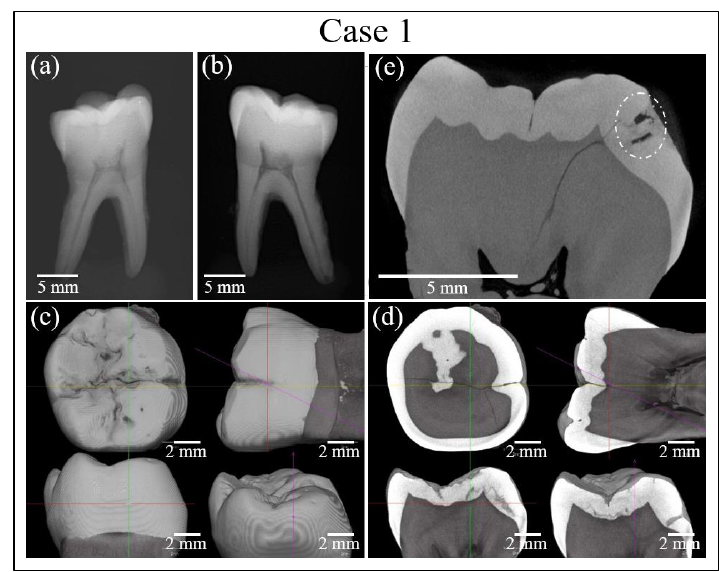
Figure 3. ( a , b ) Results of conventional X-ray analyses of the tooth sample in Case 1. ( c – e ) High-resolution micro-CT scanning examinations of the same sample. Dotted circle indicates cavity.